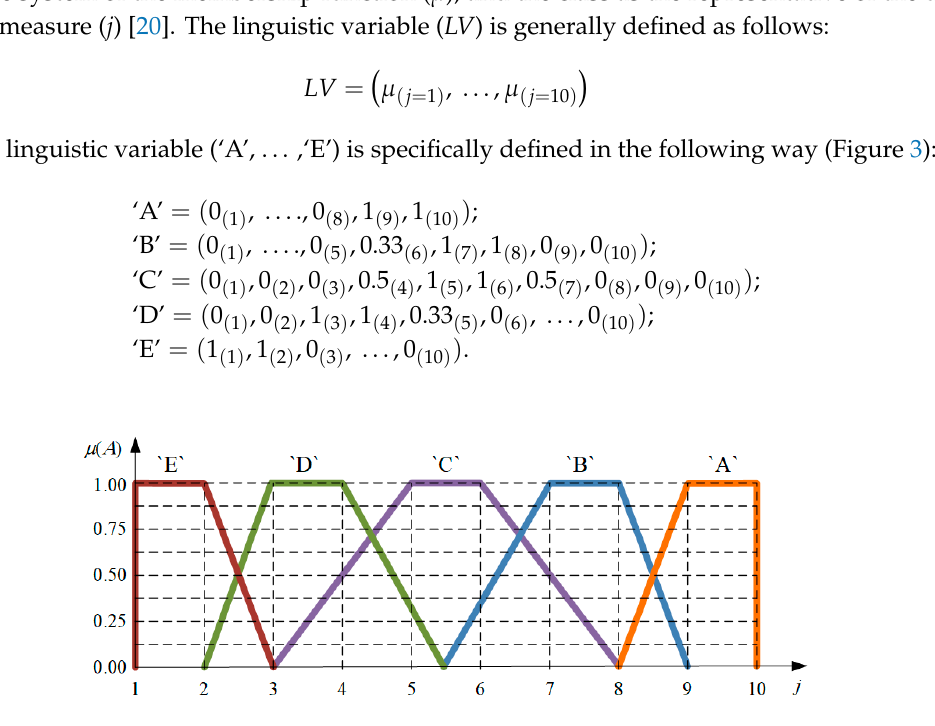
Figure 3. Dependence of linguistic variables and membership function, the general form.